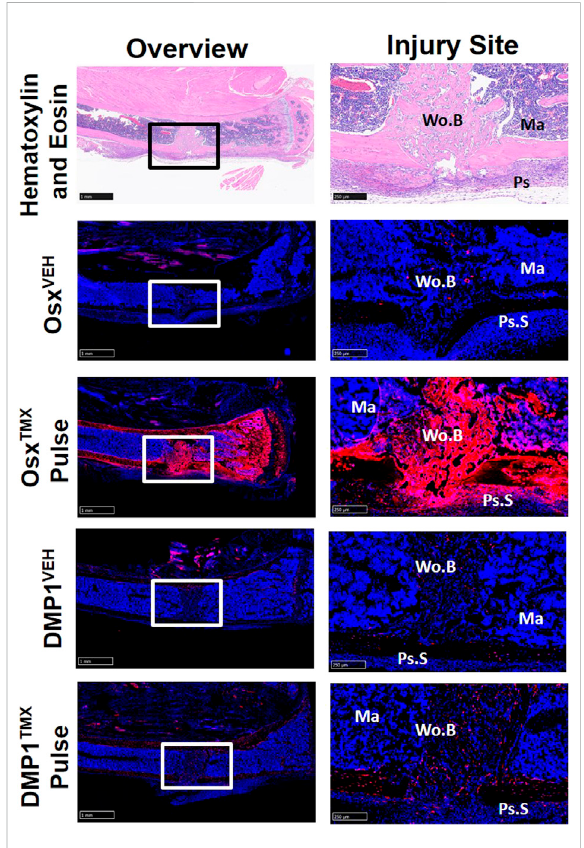
FIGURE 7 Pre-existing Osx + but not DMP1 + Lineage Cells Contribute to Woven Bone Cells During Cortical Defect Healing. 2.5X images (overview - scale bar 1 mm) and 10X images (ROI at injury site - scale bar 250 µm) centered around the PID7 cortical defect. TdTomato positive (TdT + ) cells were highly visible in woven bone (Wo.B) lining cells, osteocytes, damaged marrow (Ma) and expanded periosteal surface cells (Ps.S) from Osx TMX ; Pulse